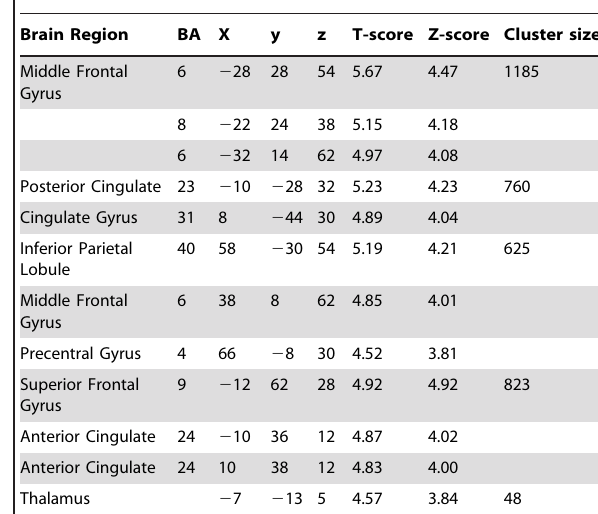
Table 2. Clusters where the SPM analysis showed significant Cues by Gender interaction (Females . Males) for p c . 0.05, cluster . 200 voxels after covarying for gender differences in daily cocaine